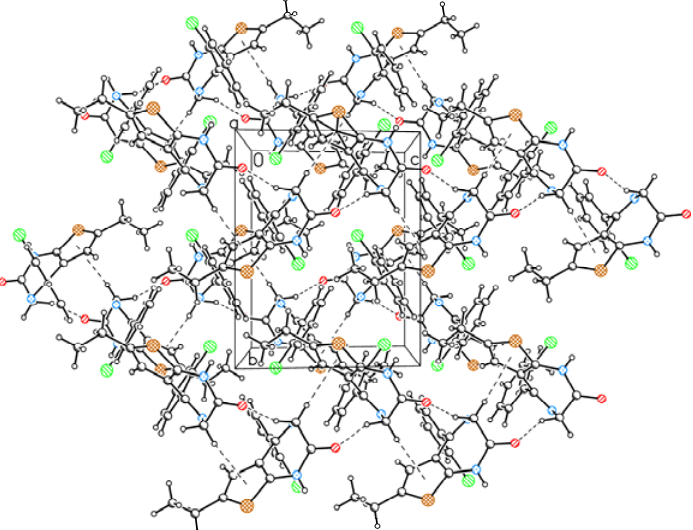
Figure 4. Crystal packing of 1 as seen approximately along [100] direction [11]; hydrogen bonds and C–H··· π interactions are drawn as dashed